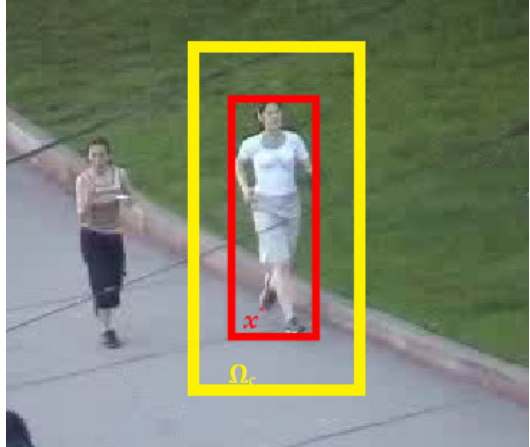
Figure 1. Spatial relation between an object and its context.